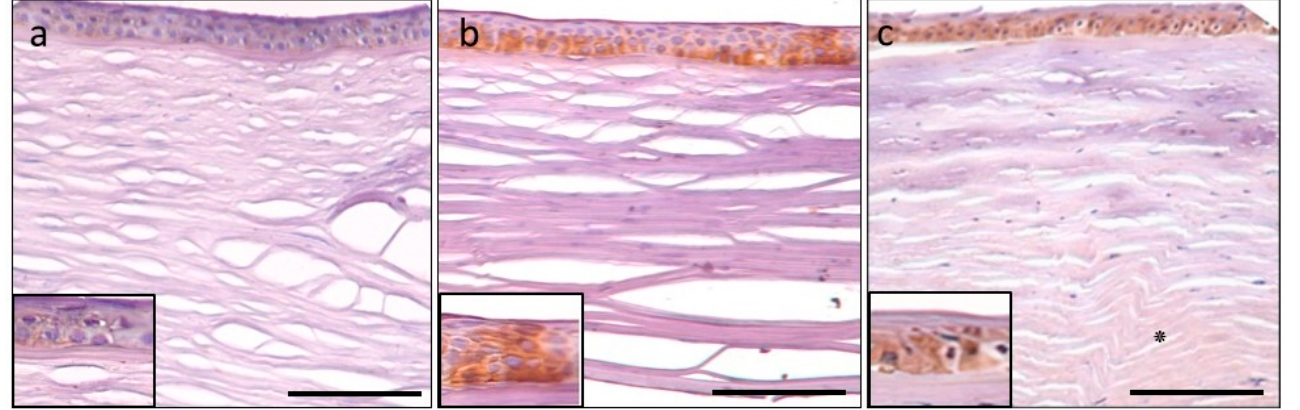
Figure 4. Tenascin-C immunohistochemistry. Control cornea with moderate positivity in the epithelium ( a ). Intense expression in PBK in the epithelium and throughout the stroma, most prominent in the pre-Descemet area (arrow) ( b ). Moderate epithelial and mild stromal staining in FECD, stromal distribution pattern is similar to PBK, with prominent posterior stromal labelling (arrow) ( c ). Epithelial signal intensity (insets). Scale bar indicates 100 µm.